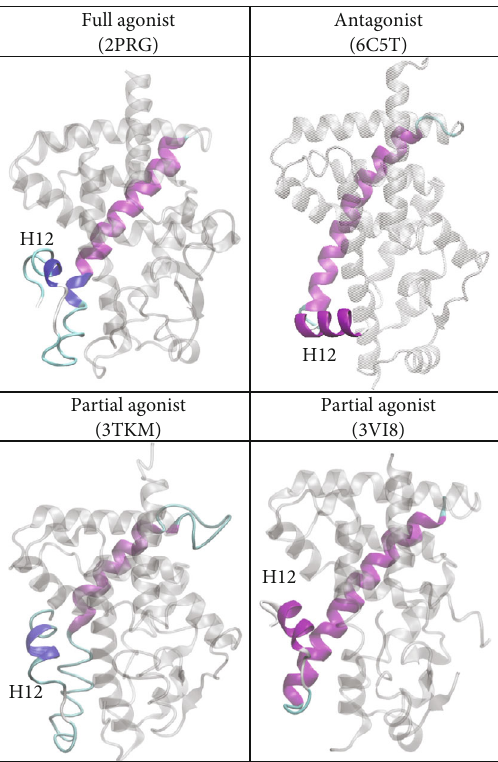
Figure 14: Proposed helix 12 conformations of the PPAR full agonist, partial agonists, and antagonist. Helices 10-11 are used as a references. Full and partial agonist conformations are derived from our simulations and antagonist conformation from the crystal structure. Coloring of helices 10-12 is based on secondary